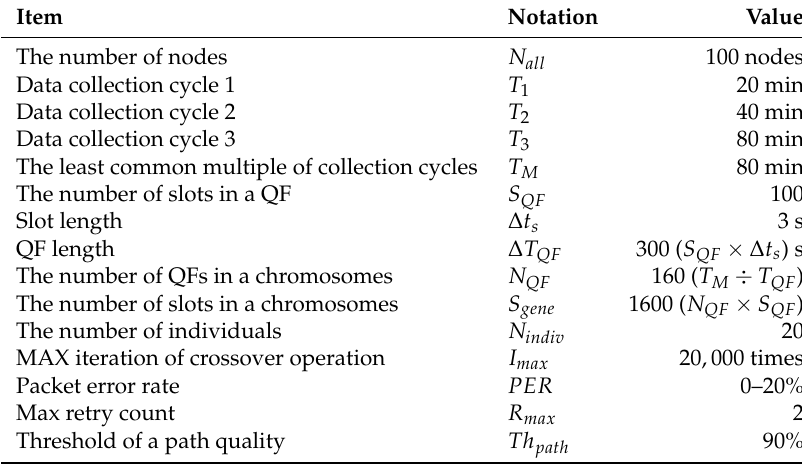
Table 4. Simulation